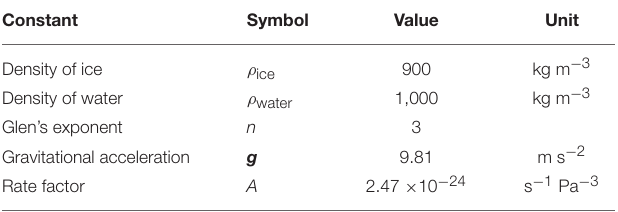
TABLE 2 | Model constants.